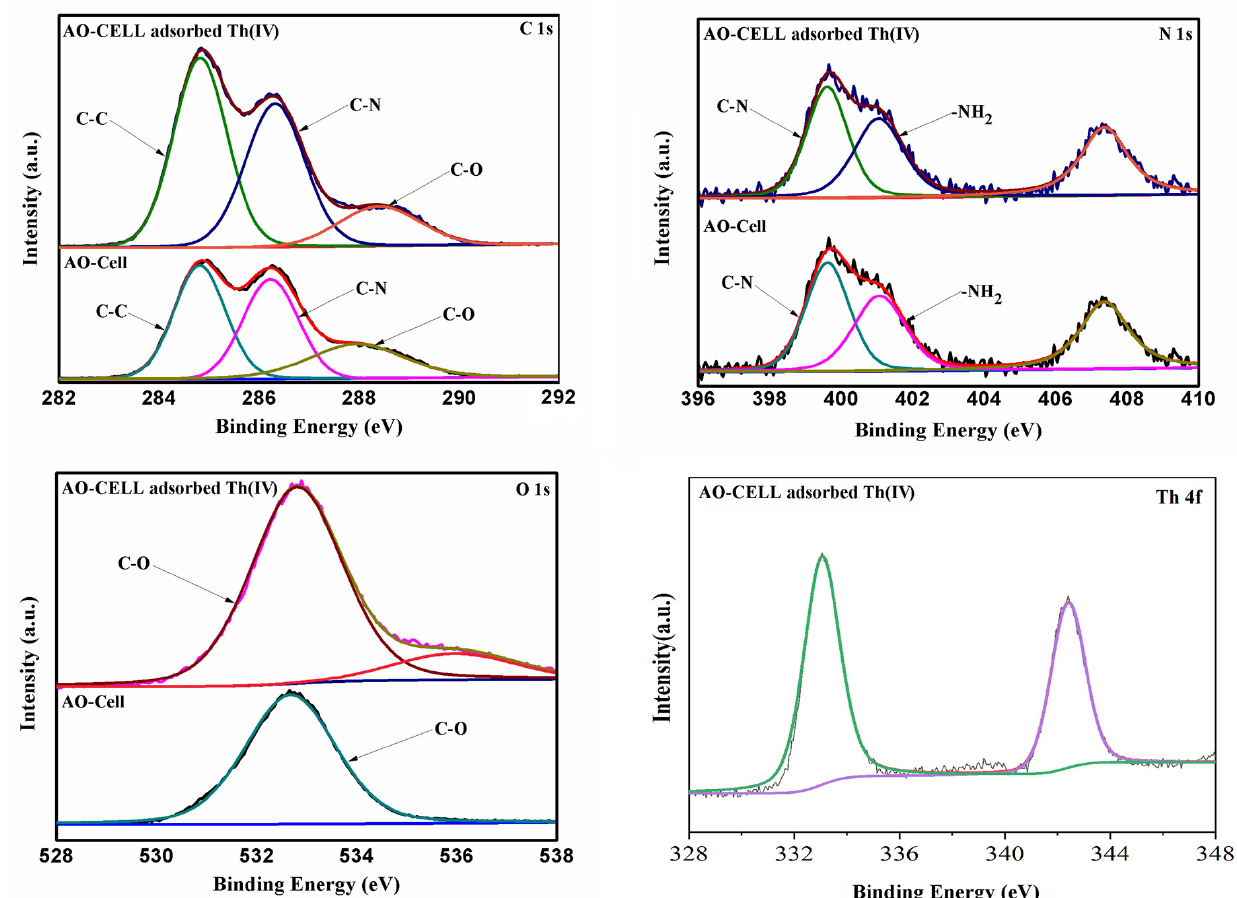
Figure 1. XPS of AO-CELL and its Th(IV) complexes.